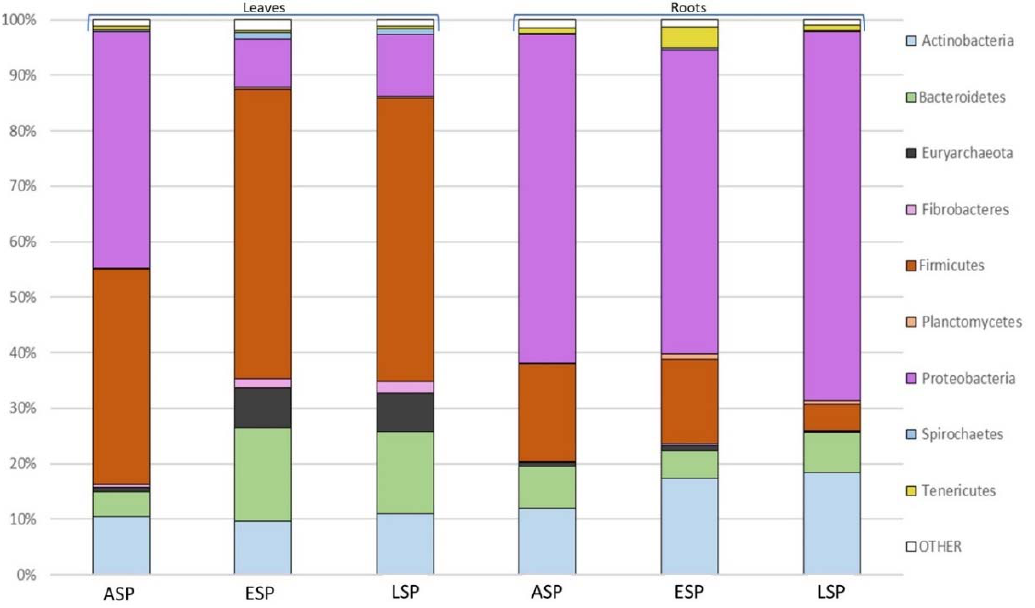
Figure 2. Graph describing the taxonomic distribution of OTUs among different organs (leaves or roots, indicated by brackets at the top) and/or sanitary statuses (asymptomatic (ASP), early symptomatic (ESP), or late symptomatic (LSP)) of examined plants at phylum level.